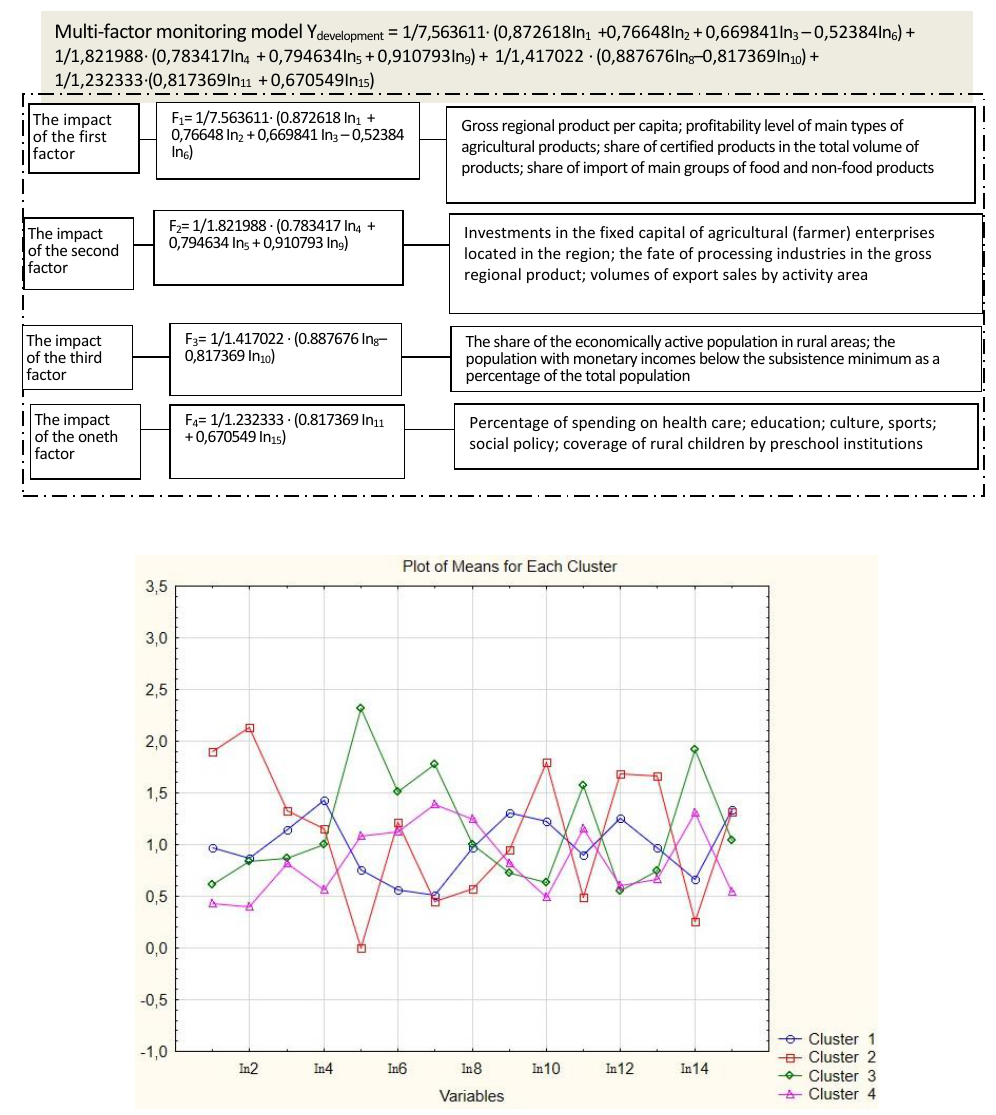
Fig. 7: Graph of average values of the socio-economic status of rural clusters in Vinnitsa region